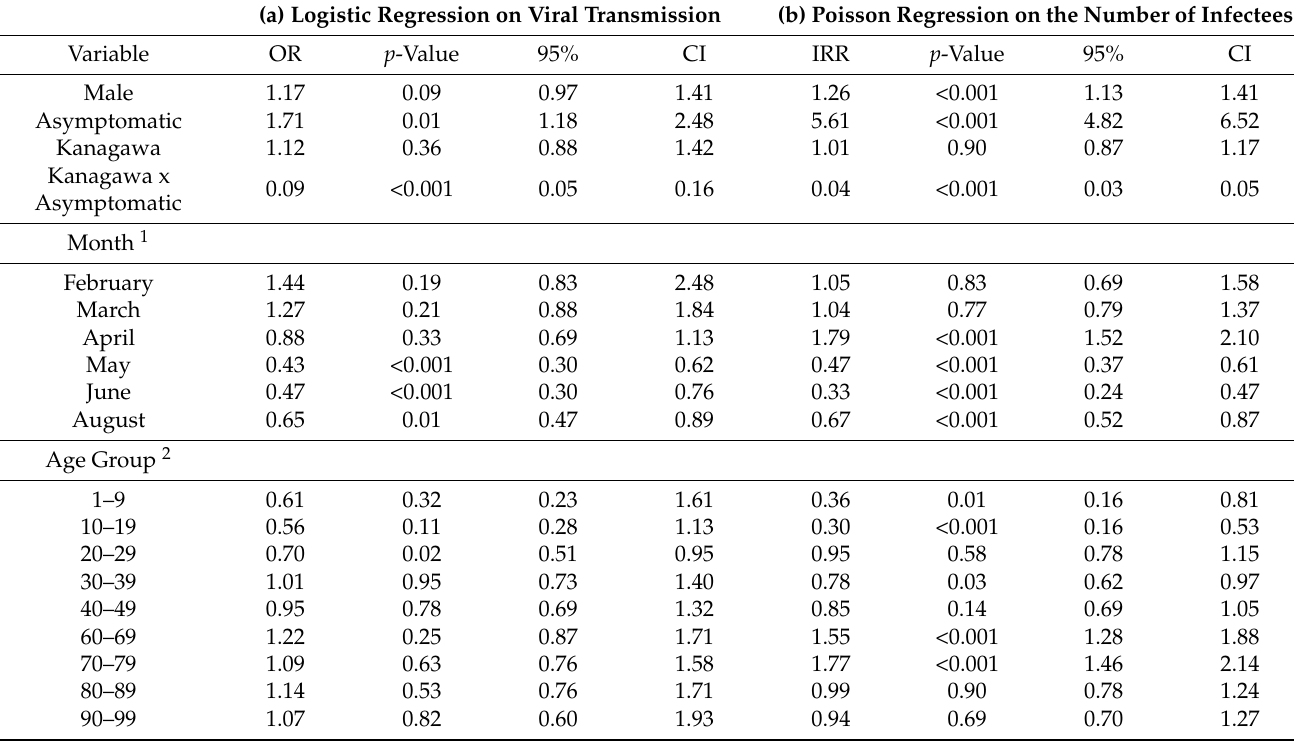
Table 4. Logistic Regression for the Determinants of Viral